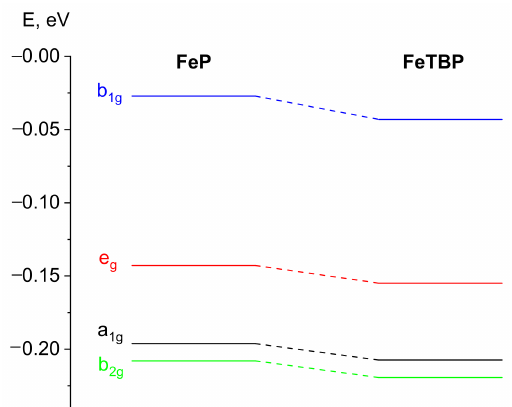
Figure 3. Energy diagram of the active in the CASSCF calculation’s molecular orbitals.